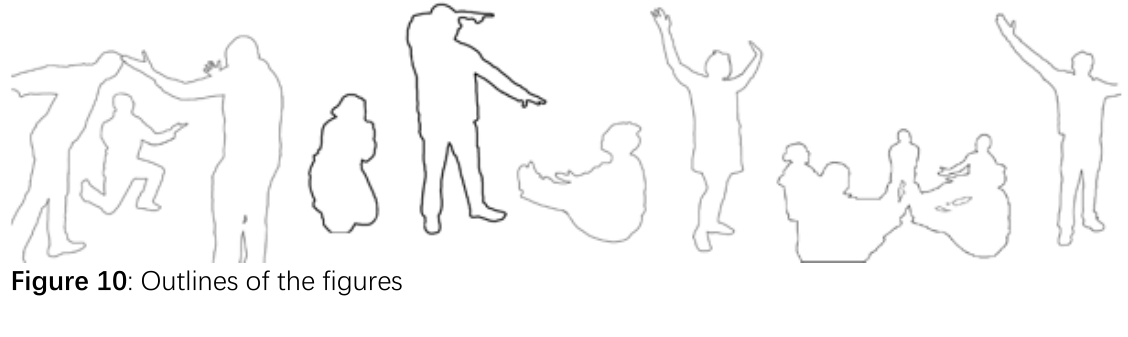
Figure 10 : Outlines of the figures Physiological Science workshops